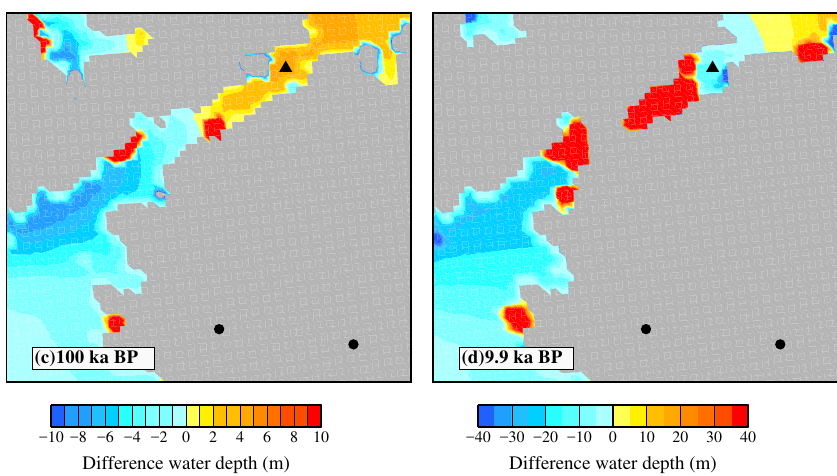
Figure 8. Examples of the influence of the choice of SSM parameter and RSL forcing on the spatial and temporal retreat pattern across the NW margin (region bounded by the blue box in Fig. 1). Panels (a) and (b) compare the grounded ice-sheet extent between two simulations Av A s _lowSSM1-0.5_shallow and HighAs_lowSSM1-0.25 to highlight the impact of the choice of A s in controlling the onset of the LGM- to-PD retreat. The red contour marks the edge of the grounded ice sheet at an earlier time step. Panels (c) and (d) illustrate the difference in the simulated water depth and maximum grounded ice-sheet extent (shaded grey region) between simulations Av A s + AvSSM1 and Av A s + AvSSM1_redSSM2. The main difference between these two simulations is the choice of SSM2 as 100myr − 1 (Av A s + AvSSM1) compared to 75myr − 1 (Av A s +